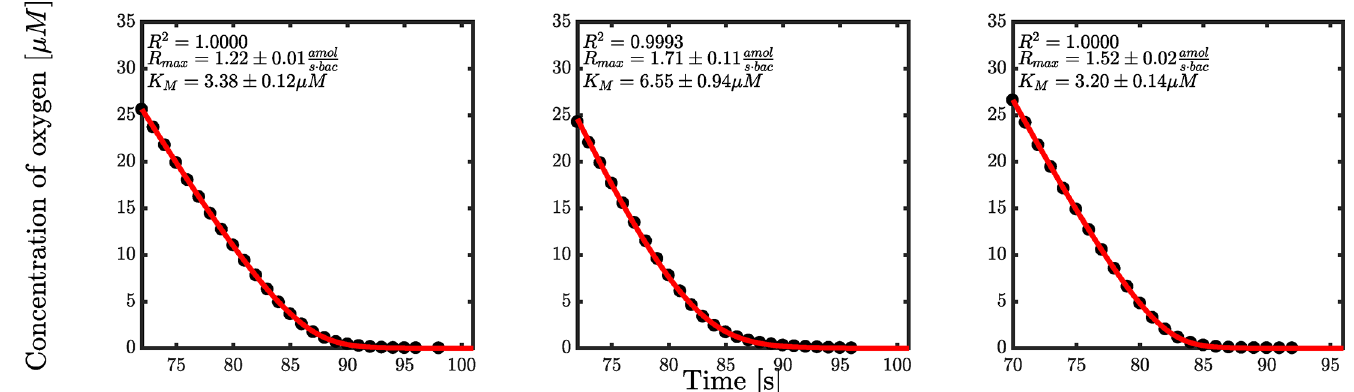
Fig 2. Oxygen consumption for overnight cultures of PAO1. Dots represent experimental data and the red lines are the solution from Eq (3) with respective parameters.